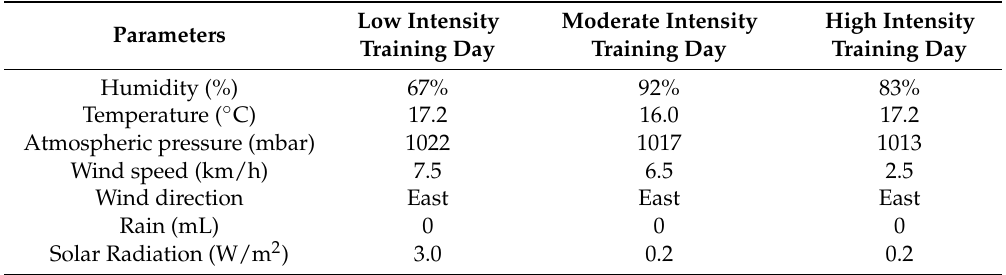
Table 2. Average values of the environmental parameters recorded during the three training sessions (low, moderate, high intensity).